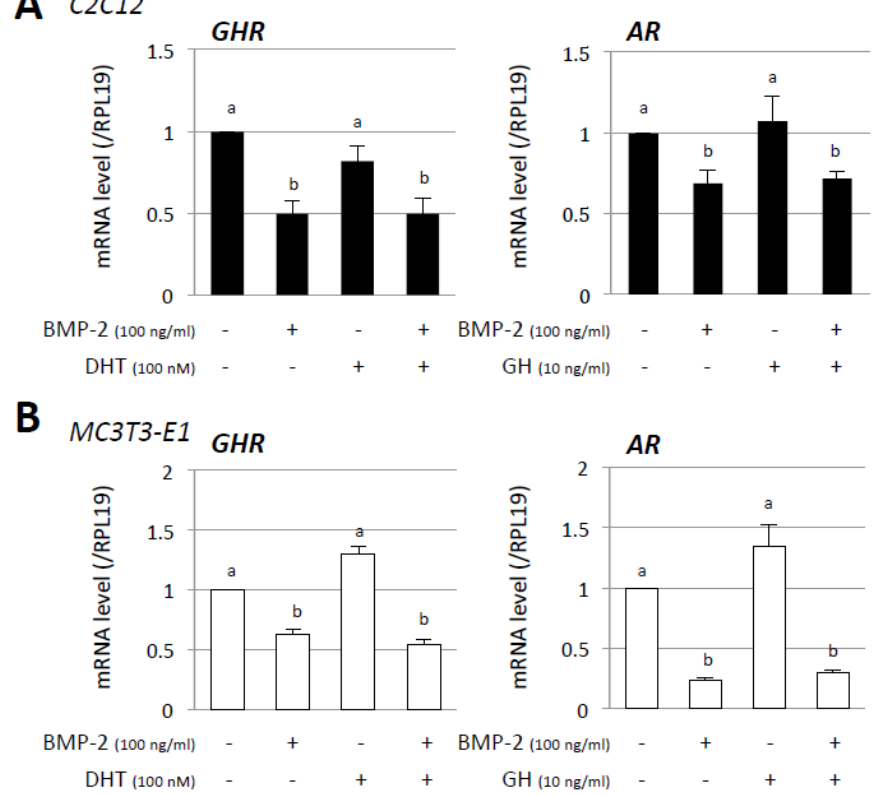
Figure 5. Mutual effects of androgen and GH on BMP-induced osteoblast marker expression. ( A ) C2C12 and ( B ) MC3T3-E1 cells (2 × 10 5 cells/well) were treated with the indicated concentrations of DHT, GH, and BMP-2 in a serum-free medium. After 48-h culture, total cellular RNA was extracted and mRNA levels of GHR and AR were examined by real-time RT-PCR. The expression levels of target genes were standardized by RPL19 mRNA levels in each sample. Results in all panels are shown as means ± SEM of data from at least three separate experiments, each performed with triplicate samples. The results were analyzed by ANOVA. For each result within a panel, the values with different superscript letters are significantly different at p < 0.05.